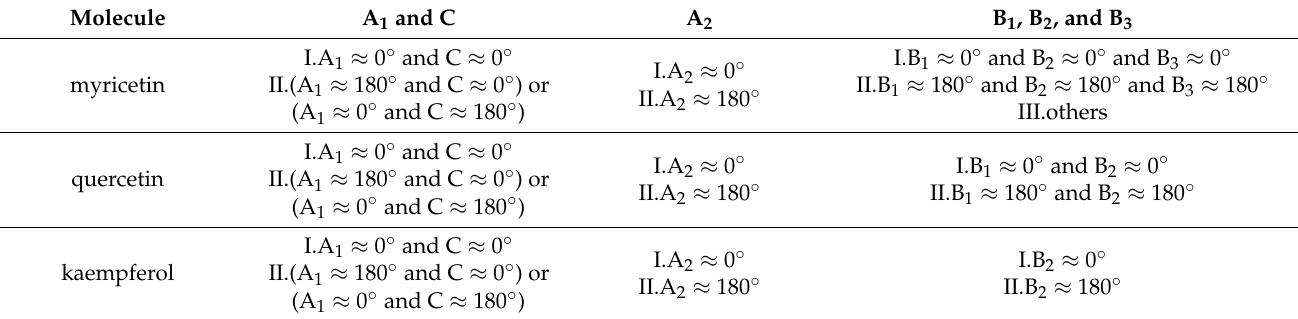
Figure 3. Definition of the dihedral angles representing the orientation of hydrogen atoms of each hydroxy group. The four atoms constituting a dihedral angle are represented using orange and blue balls and lines. Table 2. The combinations of the orientation of hydrogen atoms in each hydroxy group.